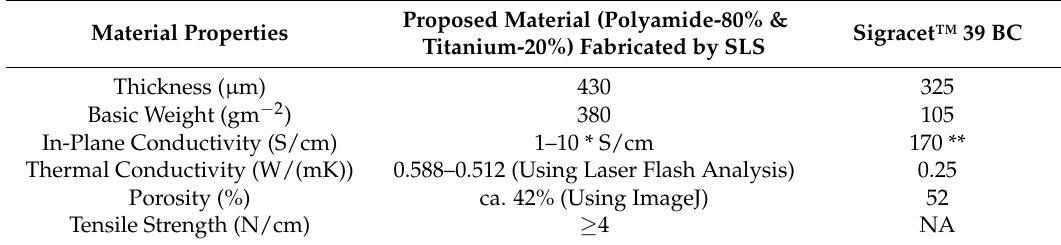
Table 4. Comparison of functional properties of the proposed material with Sigracet™ 39 BC [8].